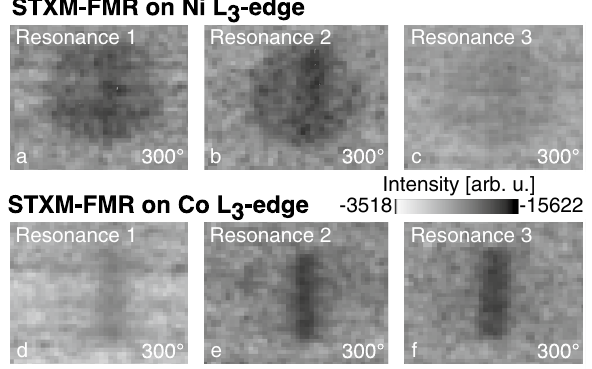
Figure 3. STXM-FMR images taken at the respective B ext for resonance 1, 2, and 3. ( a )–( c ) are recorded at the Ni L 3 -edge, ( d , e ) are recorded at the Co L 3 -edge. The STXM-FMR images correspond to the time slot at 92 ps ◦ (300